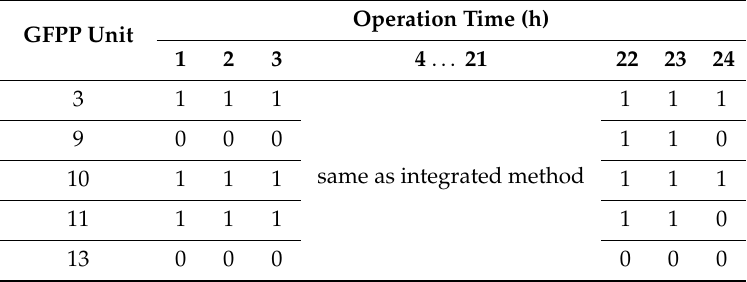
Table 2. Commitment status of GFPPs in separated method.